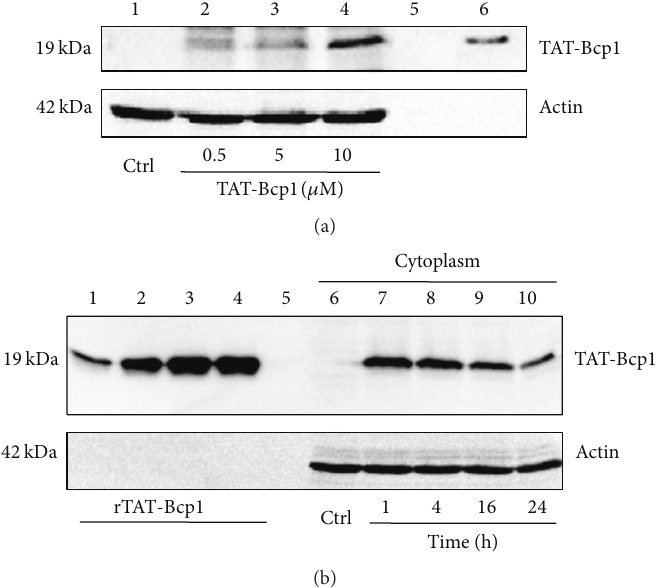
Figure 4: Transduction of TAT-Bcp1 in H9c2 cells. A western blot analysis of the cytoplasmic extracts was performed to detect TAT-Bcp1 in the H9c2 cells; the cytoplasmic proteins were analysed with a penta-His HRP-conjugated mAb. Actin was used as the cytoplasmic marker (lower panels). (a) H9c2 cells were cultured in growth medium (lane 1) and incubated with 0.5 𝜇 M (lane 2) , 5 𝜇 M (lane 3) , and 10 𝜇 M (lane 4) TAT-Bcp1 for 1h. Purified TAT-Bcp1 was loaded as reference ( lane 6 ). (b) H9c2 cells were cultured in growth medium (lane 6) and incubated with TAT-Bcp1 (10 𝜇 M) for 1h (lane 7) , 4h (lane 8) , 16h (lane 9), and 24 h (lane 10) . Increasing amounts of purified TAT-Bcp1 were loaded to construct a calibration curve to determine the intracellular TAT-Bcp1 levels: 25 ng (lane 1) , 50 ng (lane 2) , 75 ng (lane 3) , and 100 ng (lane 4)